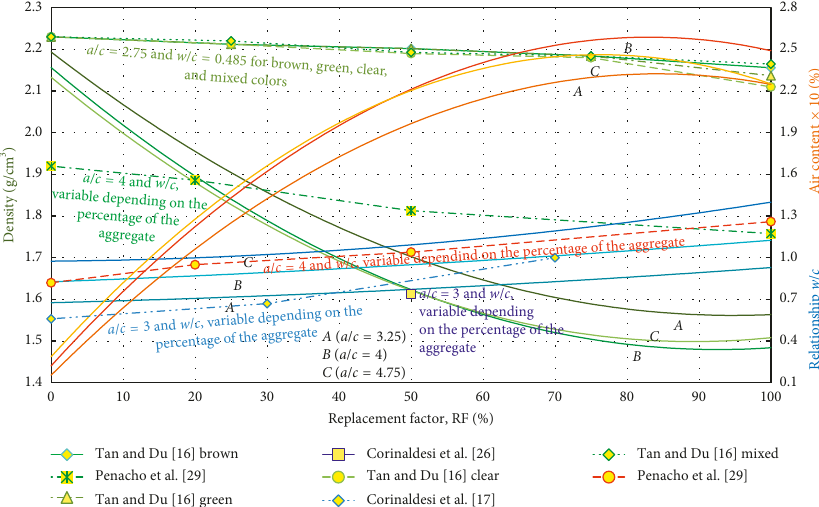
Figure 5: Triple interaction diagram and results of previous